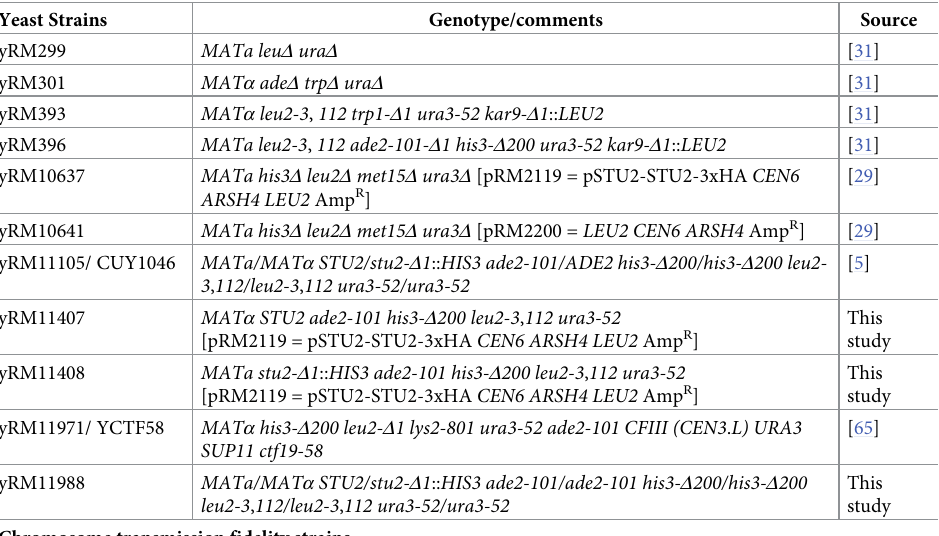
Table 1. Yeast and bacteria